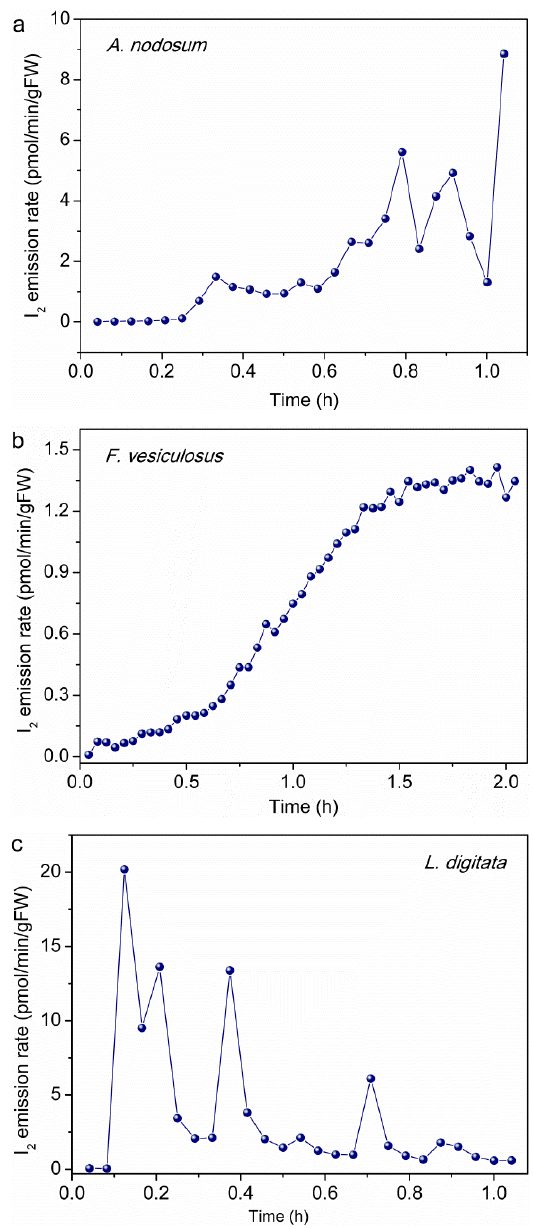
Fig. 5. A typical time-dependent I 2 emission rate of A. nodosum (a) , F. vesiculosus (b) and L. digitata (c) when exposed to 50ppb O 3 in synthetic air in a simulation chamber (modified from Kundel et al.,